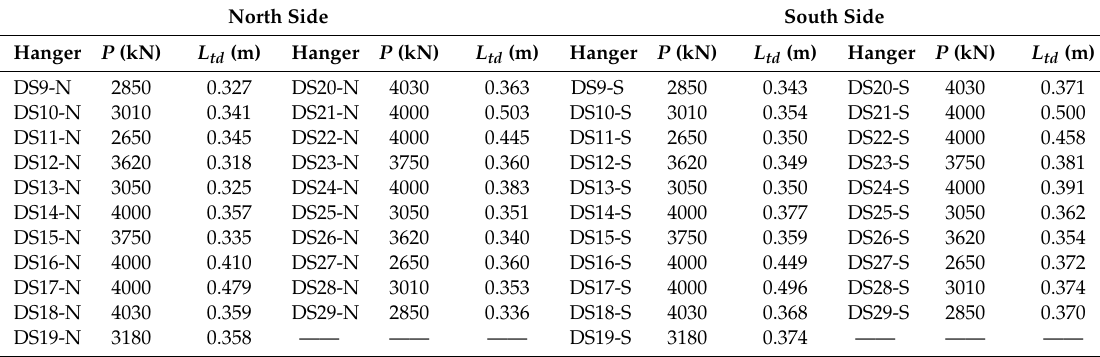
Table 7. Target values of the control parameters of tensioning round